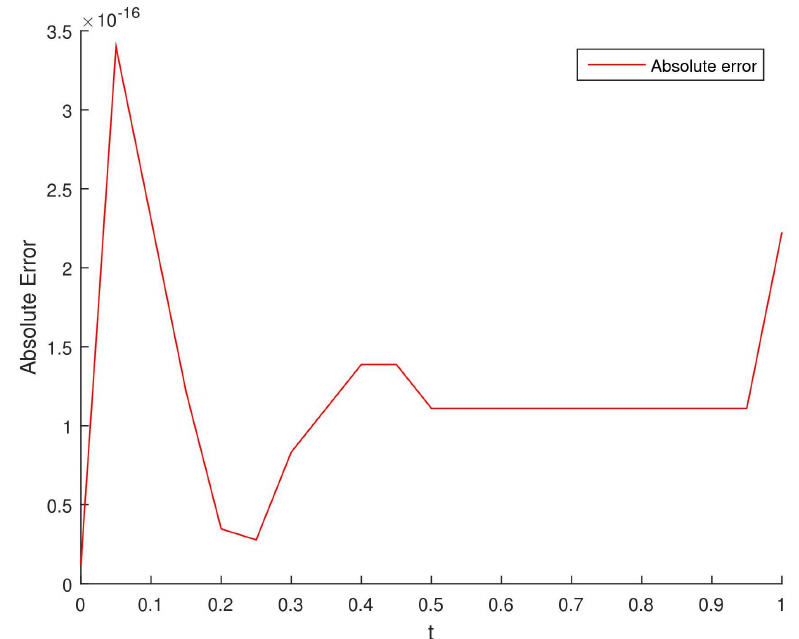
Figure 10. The behaviour of absolute error for Example